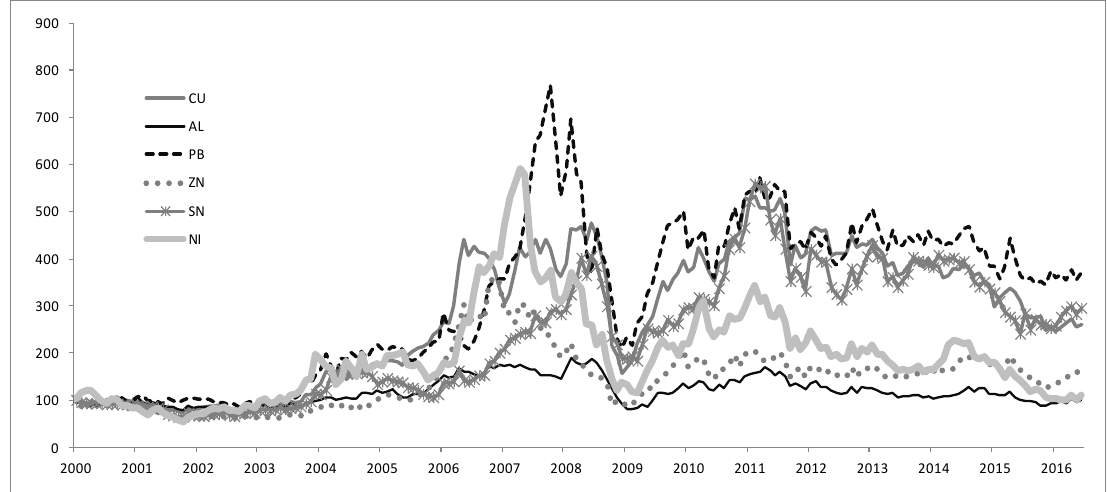
Figure 1. Plot of base metal prices (normalized by their January 2000 value).